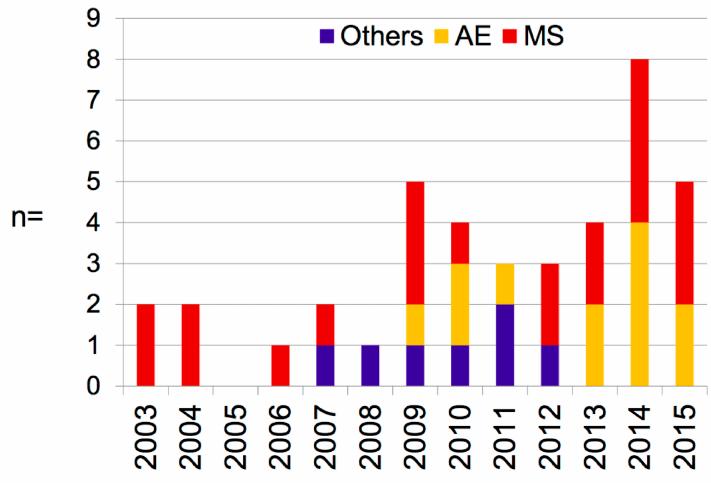
Figure 2. Time course of therapeutic plasma exchange (TPE) usage during the observation period.